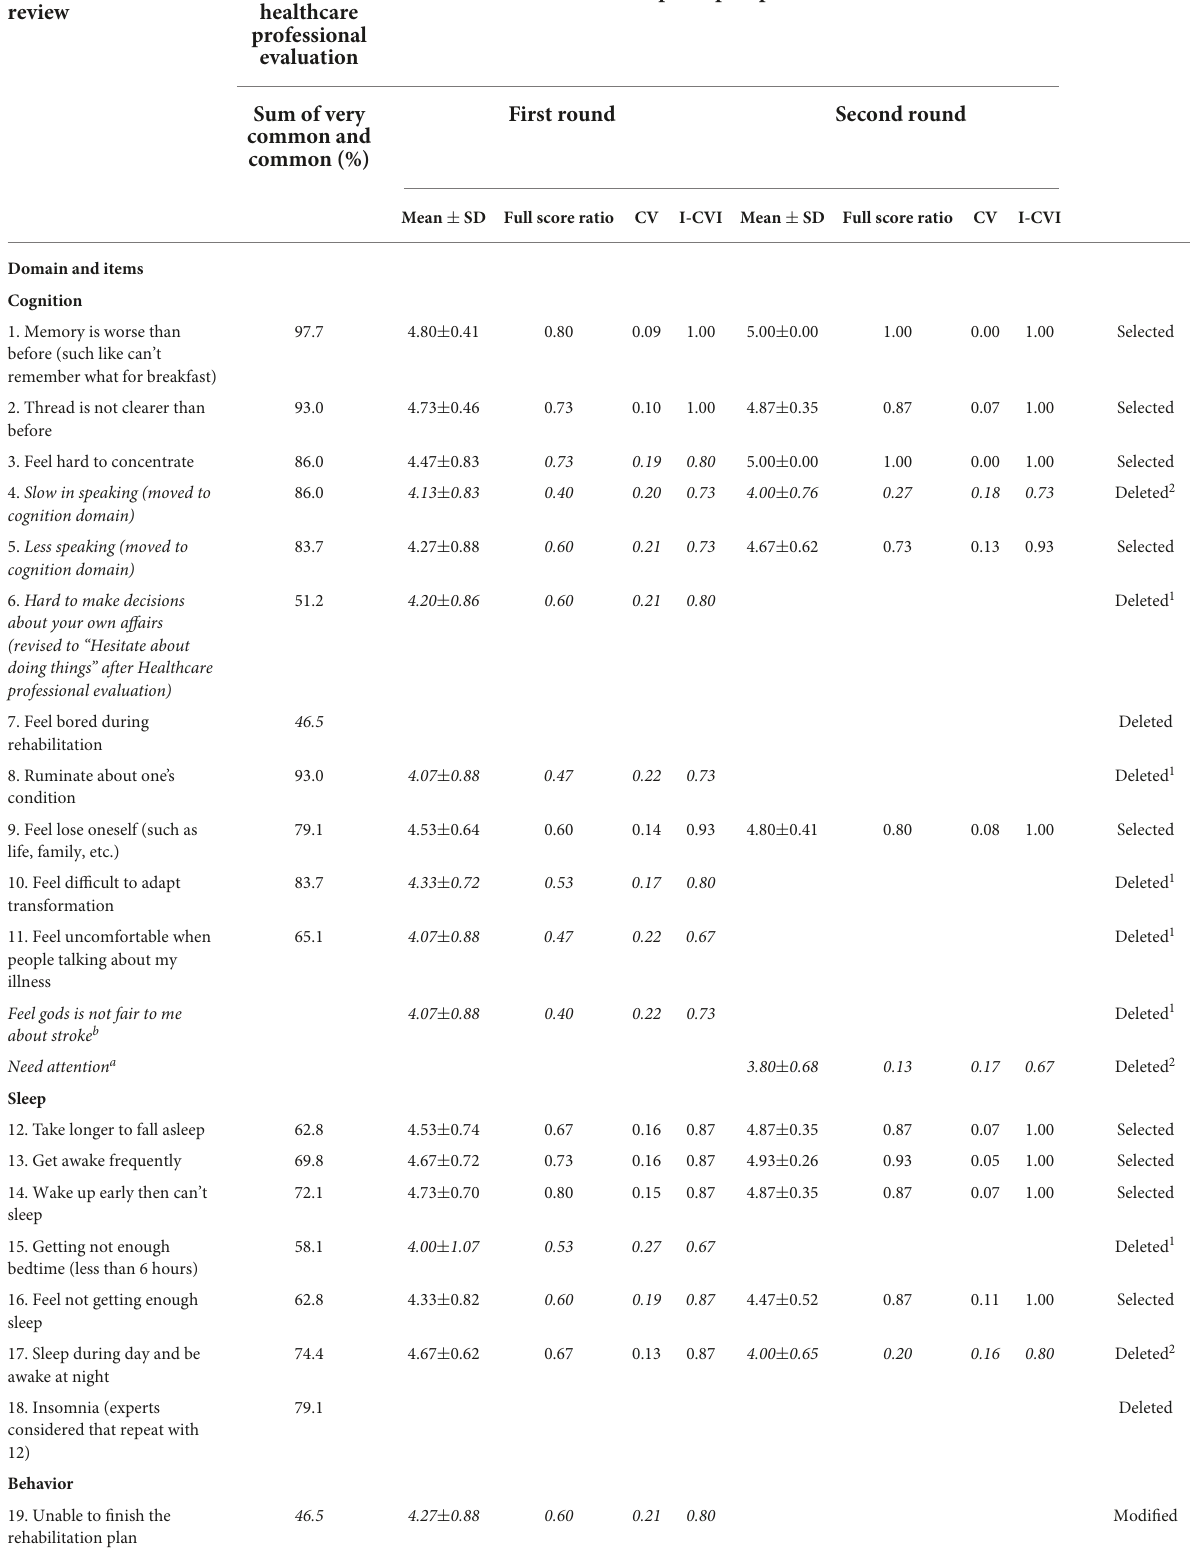
TABLE 1 Development and initial validation of post-stroke depression measure for the rehabilitation stroke